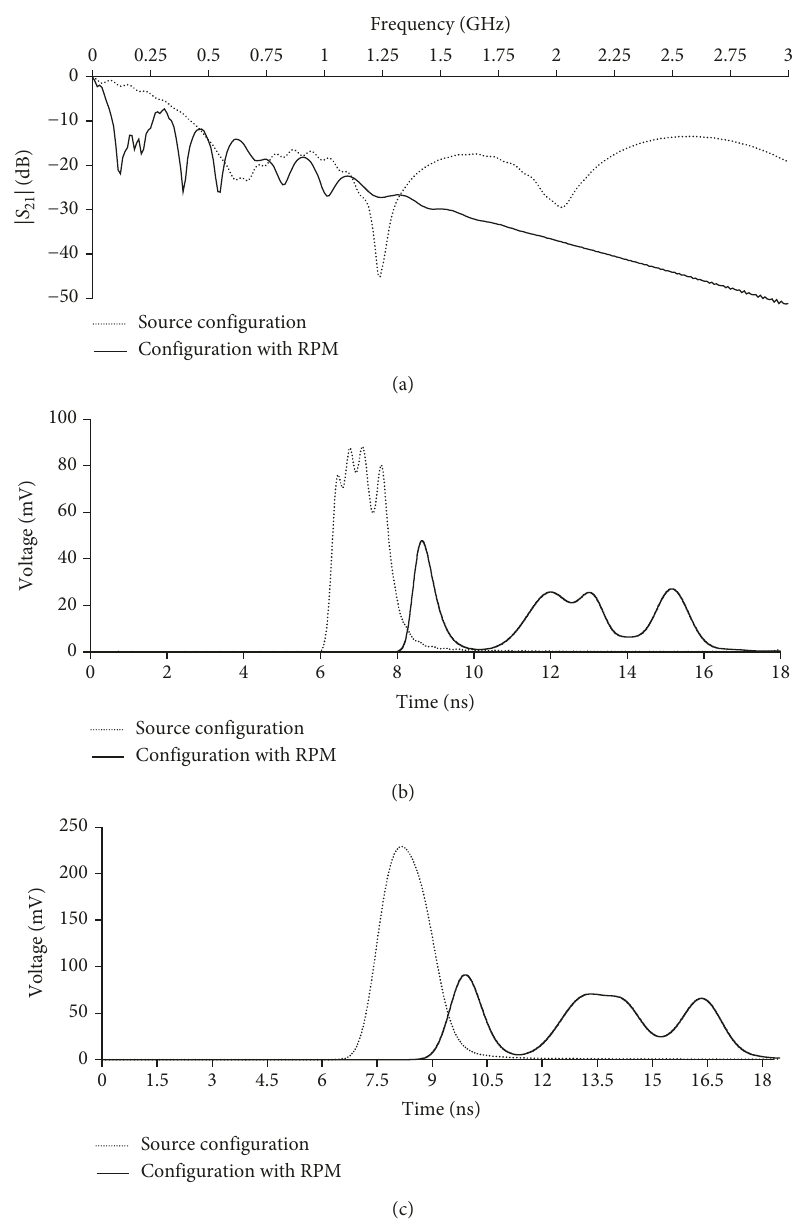
Figure 8: Characteristics of the two structures with MR: ( a ) frequency dependences of | S the duration of (b) 0.8 and (c) 2.4ns. Table 3: Cutoff and first resonance frequencies, as well as the maximum voltage at the output under the influence of USPs. Parameters f c , MHz f r , MHz Source